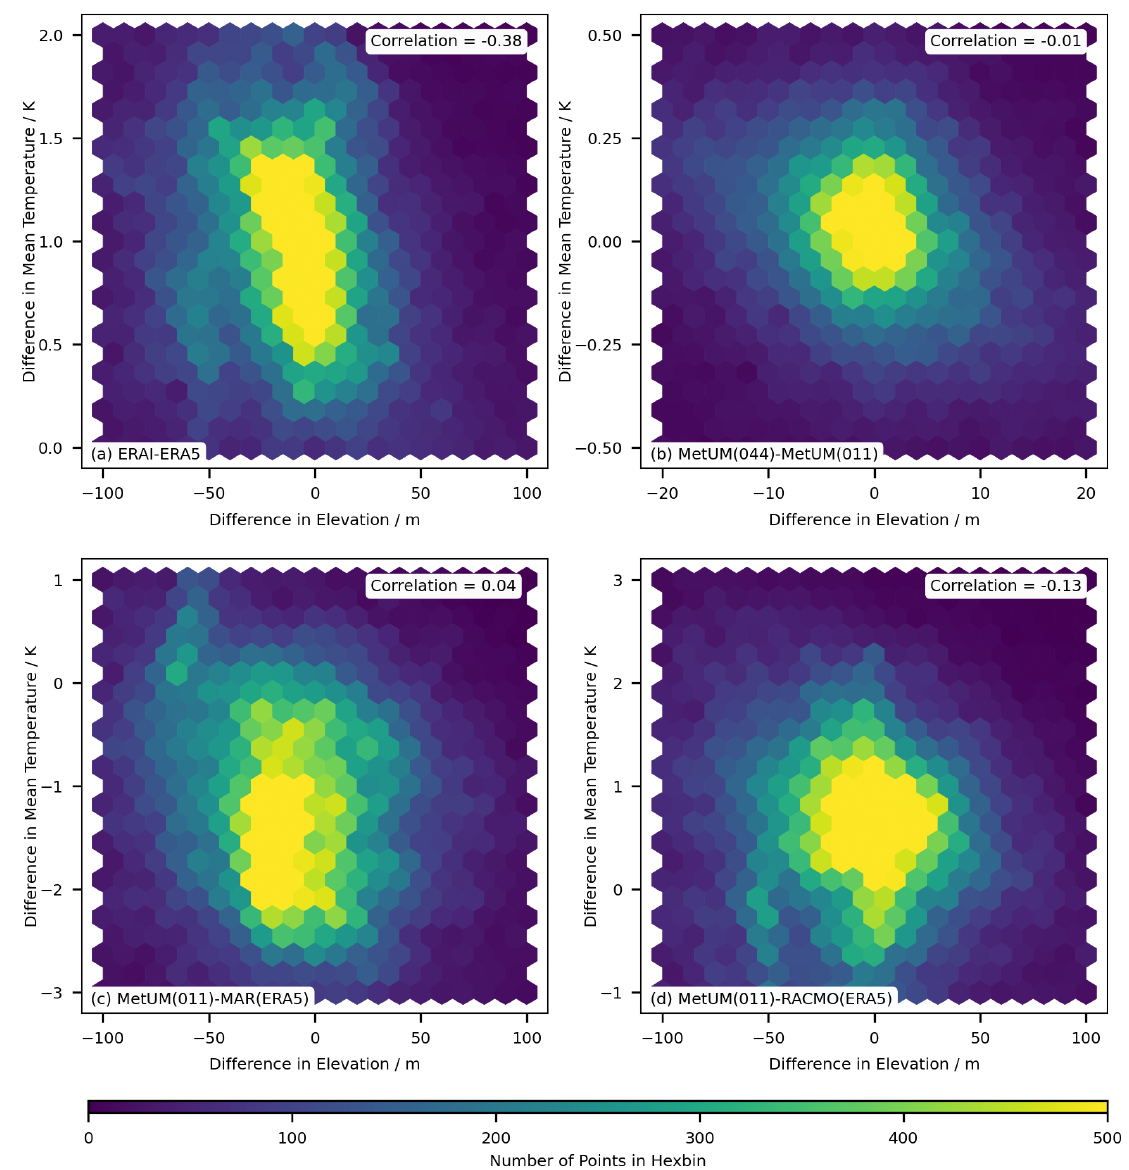
Figure C2. A density scatter plot showing the correlation between the difference in elevation for each model relative to the ensemble and the difference for near-surface temperature in the mean of the time series (a) , the standard deviation of the seasonal component (b) and the standard deviation of the residual component (c) . The linear Pearson correlation coefficient is given for each